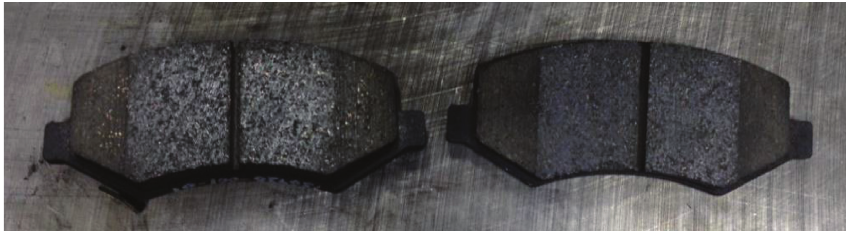
Figure 11: Brake pads after chamfering.